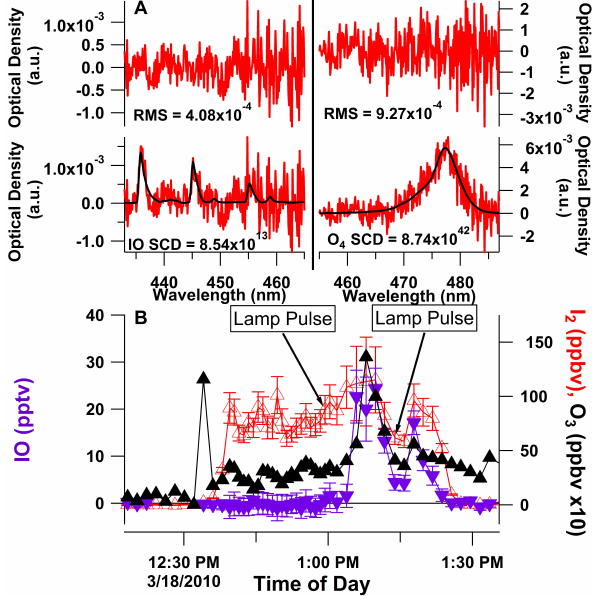
Fig. 7. (A) Example spectrum for the IO detection (4.4pptvIO, 62ppbvI 2 ) (left panel) with the corresponding O 4 fit (right panel). (B) Time trace showing the variations in IO, O 3 and I 2 , as inferred from the reduction in O 4 path length. The detection limits for IO (dashed line) and I 2 (dotted line) increase towards longer wave- lengths because of extinction losses due to I 2